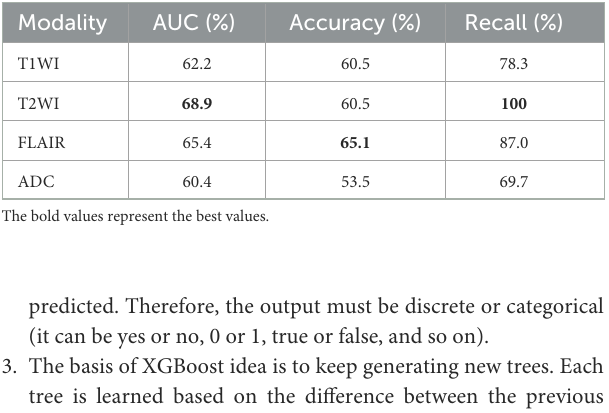
TABLE 1 Comparison of classification performance based on different